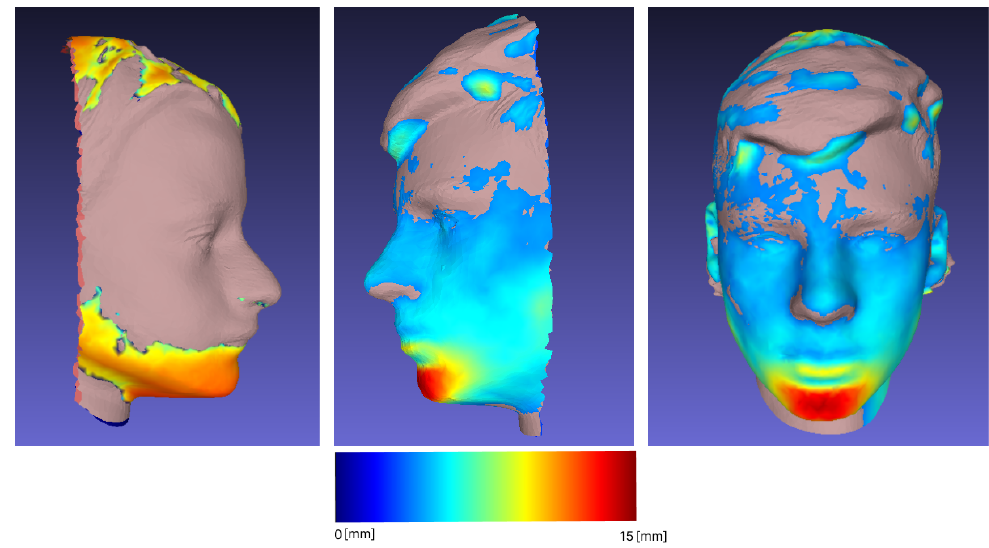
Figure 6. Multiple examples of forward